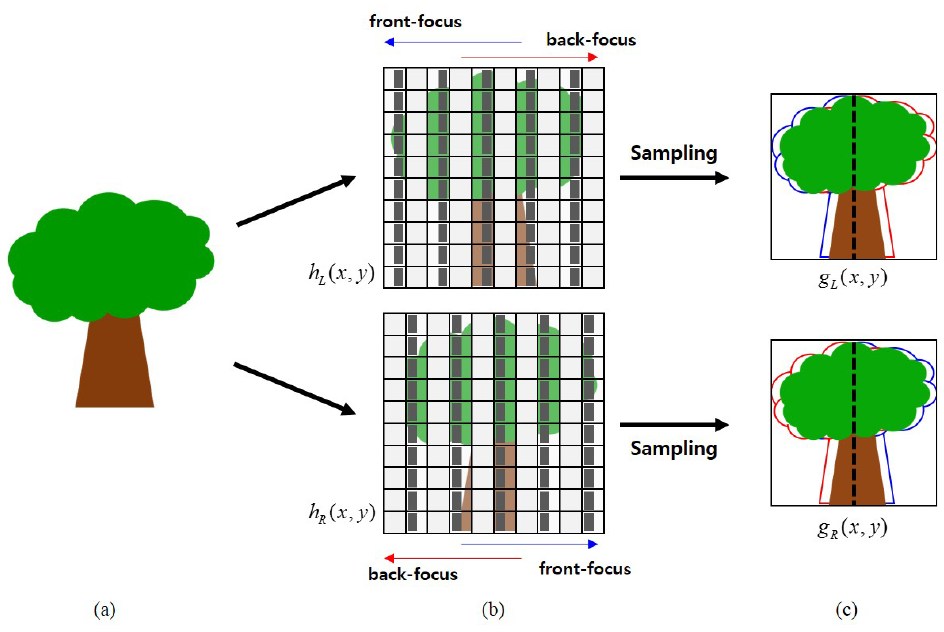
Figure 7. Phase difference generation process: ( a ) an object in the real world; ( b ) left (top) and right (bottom) phase sensor configuration with the appropriate masking; and ( c ) the acquired left (top) and right (bottom) phase images.